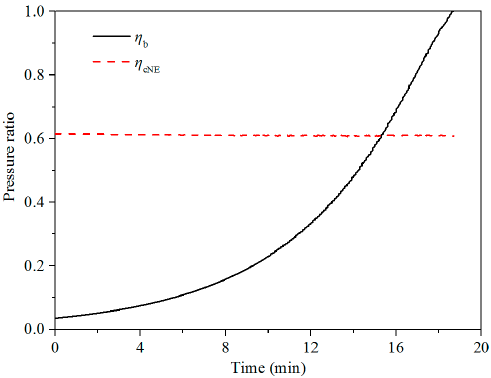
Figure 8. Changes in the tank pressure, outlet pressure, and the difference between the tank and outlet pressures over the leakage duration time.